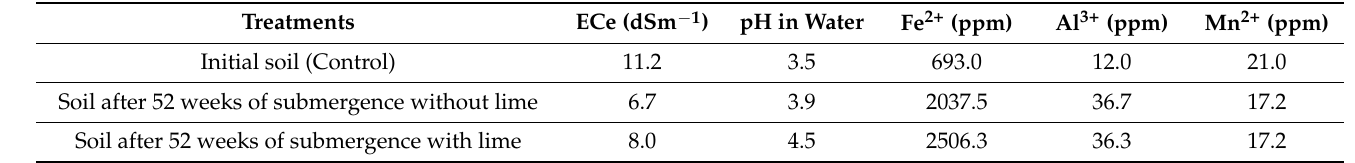
Table 5. Effect of long-term submergence on acid saline soils of the Ganges Delta with and without lime